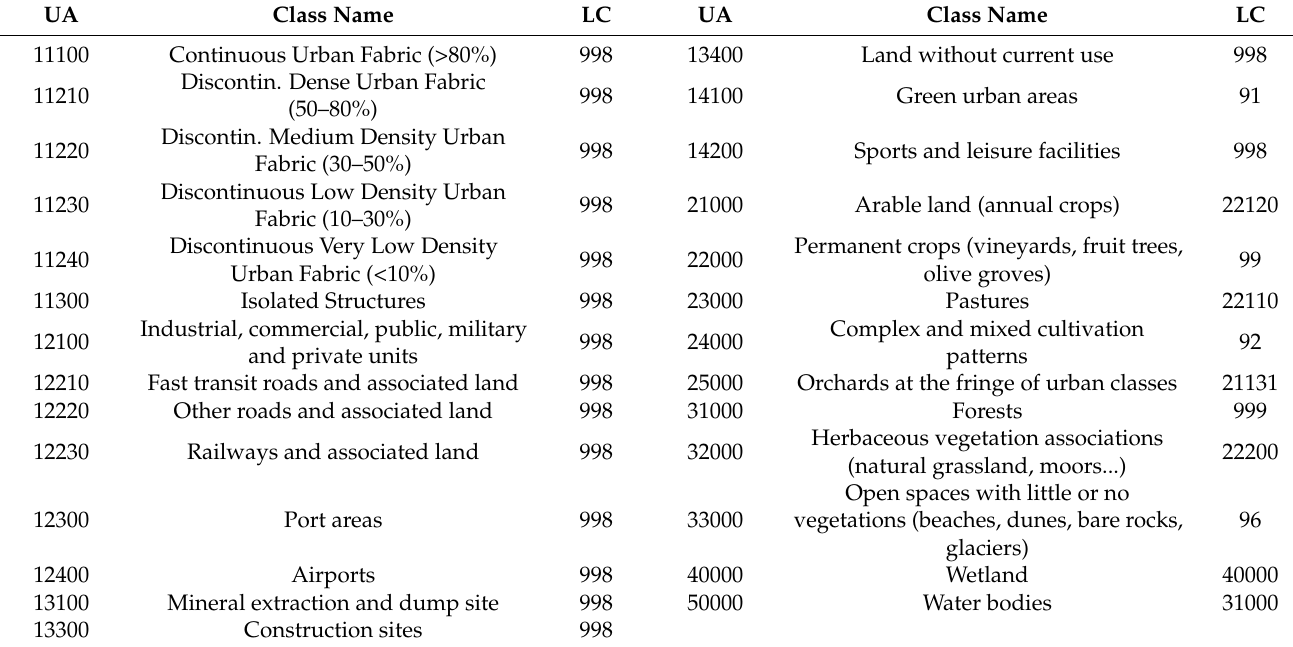
Table A2. Reclassification table for